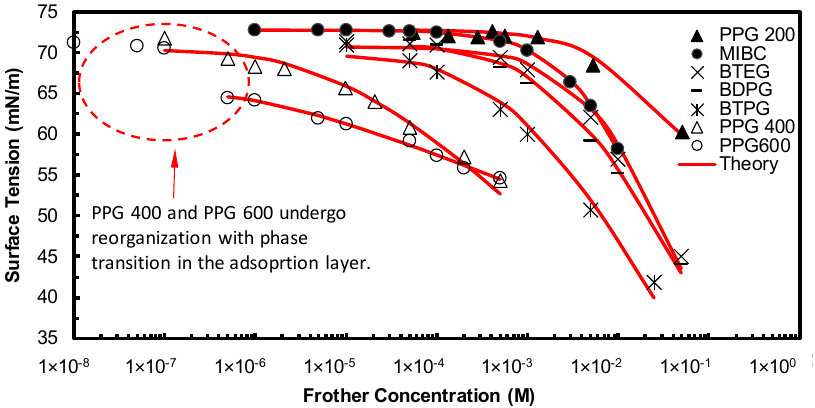
Figure 4. Experimental and theoretical surface tension isotherms.